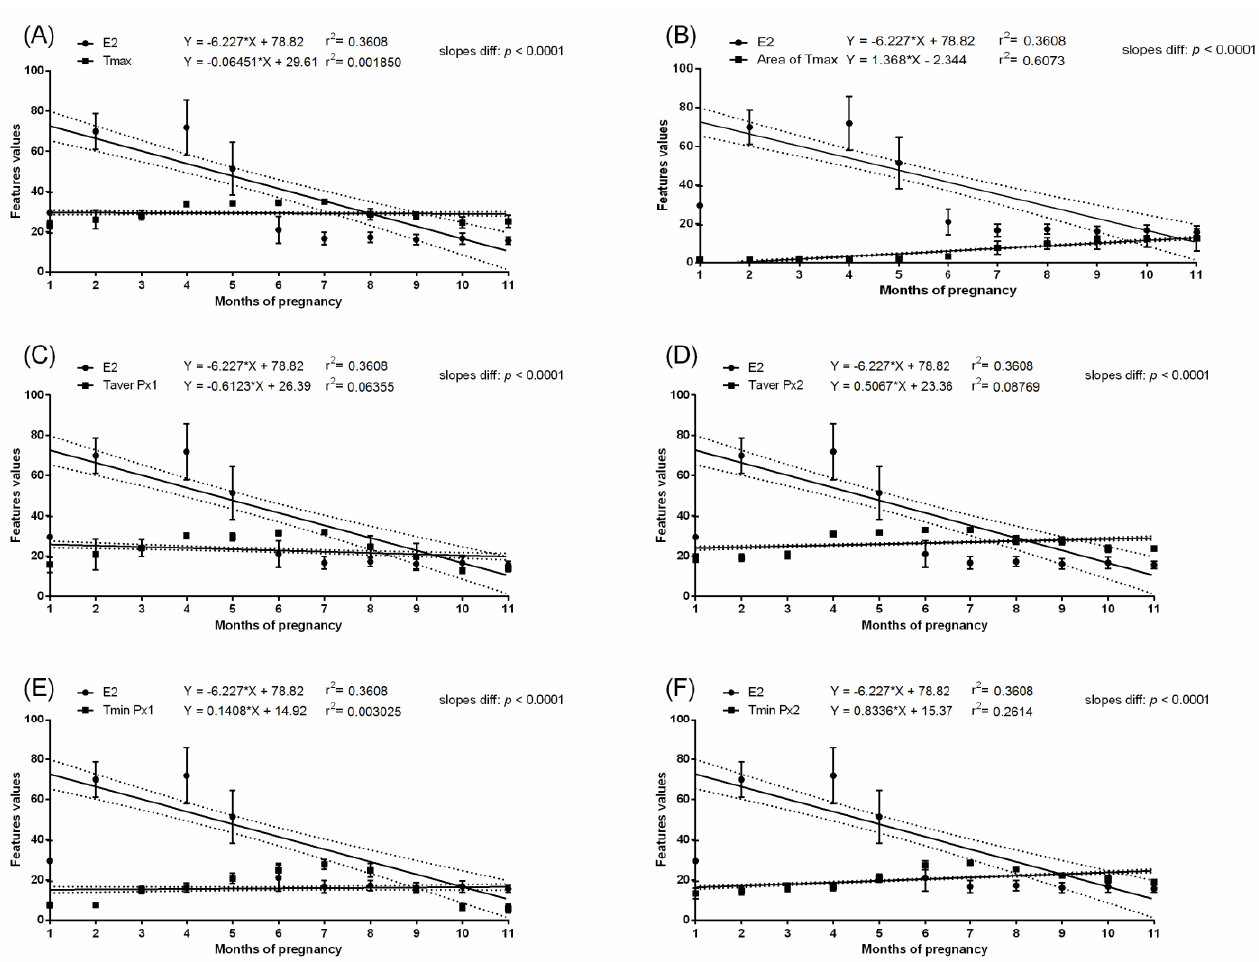
Figure 5. Linear regressions of 17-ß estradiol concentration in the serum and selected thermal features of the lateral surface of the abdomen in pregnant mares: the maximal temperature in Px1 and Px2 ( A ); the area with the highest temperatures in the range of 3 °C ( B ); the average temperature in Px1 ( C ); the average temperature in Px2 ( D ); the minimal temperature in Px1 ( E ); the minimal temperature in Px2 ( F ).